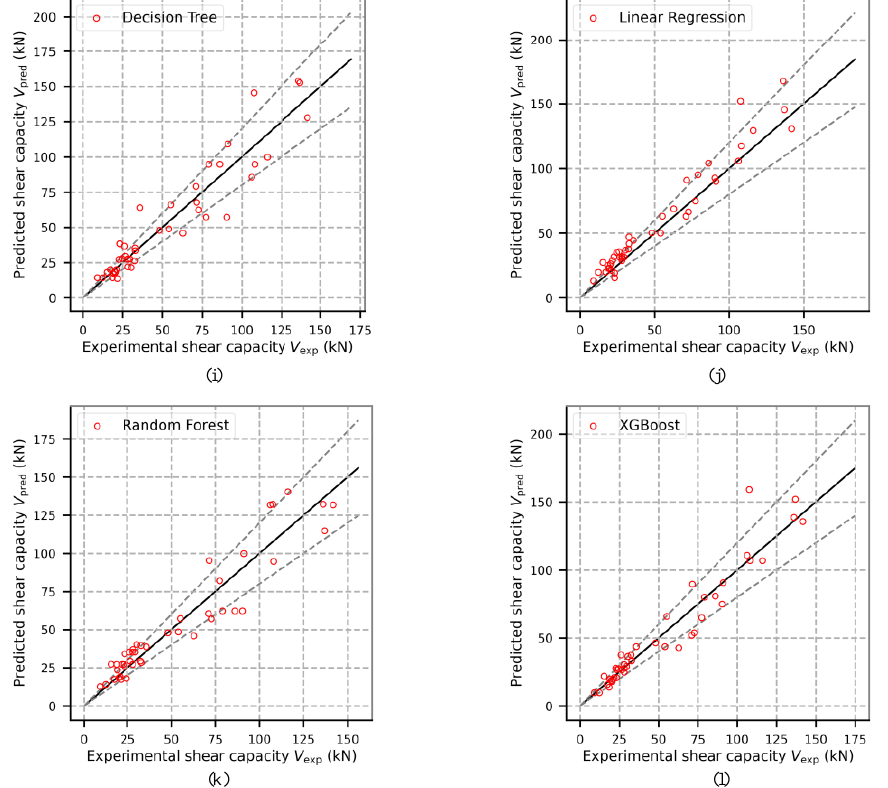
Figure 6. Comparisons of test results and predictions of shear design provisions and ML models: shear design provisions: ( a ) ACI 440, ( b ) CSA S6, ( c ) CSA S806, ( d ) JSCE; basic ML models: ( e ) Decision Tree, ( f ) Linear Regression, ( g ) Random Forest, ( h ) XGBoost; ML models with additional features: ( i ) Decision Tree, ( j ) Linear Regression, ( k ) Random Forest, ( l ) XGBoost.